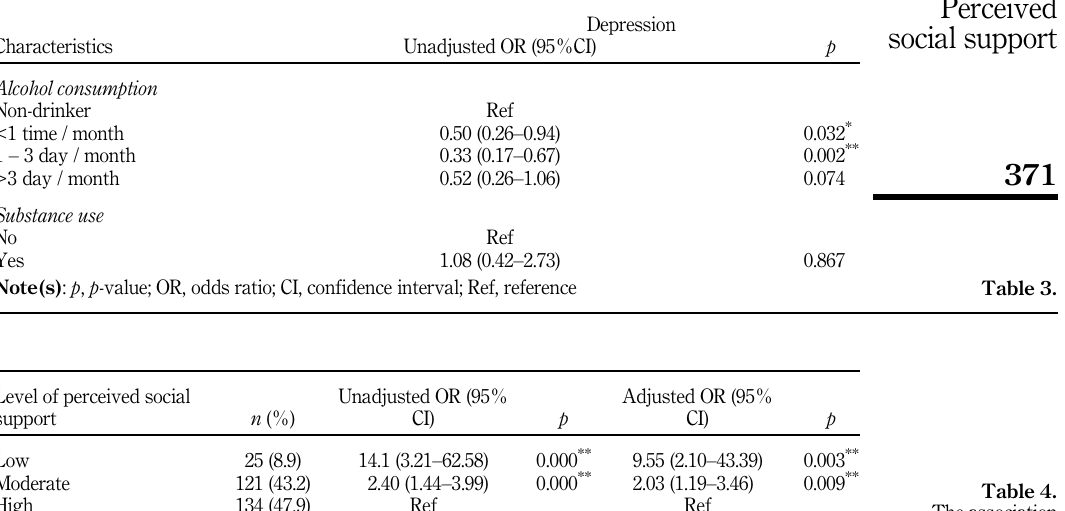
between social support and